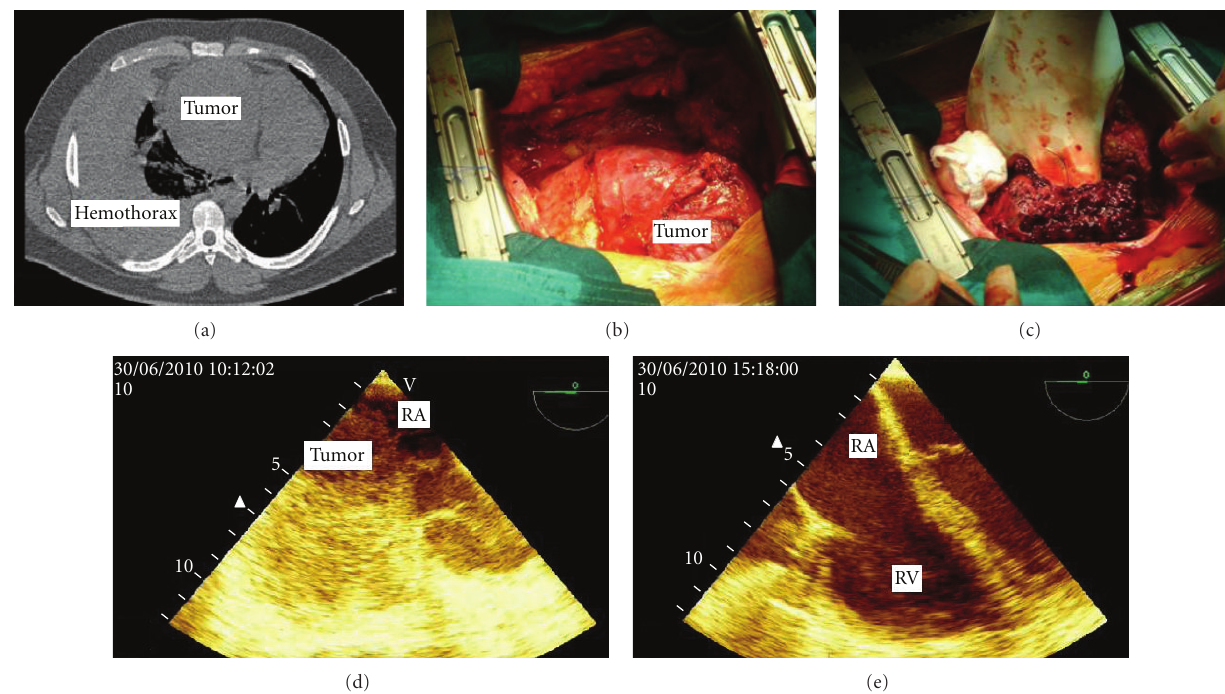
Figure 1: (a) Chest CT; (b) Tumor in RA displayed sternotomy (c) extensive necrosis and hemorrhage of the tumor to manipulation; (d) peroperative transesophageal echocardiogram, showing compression of RA, resolved after resection of the tumor (e) RA: right atrium; RV: right ventricle.